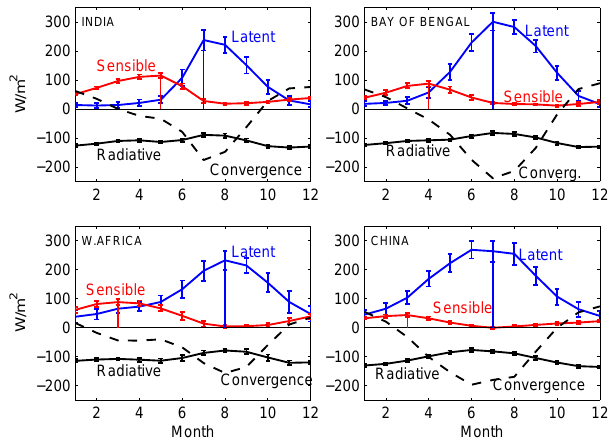
Fig. 2. Seasonal heat flux contributions to the atmospheric column over four major continental monsoon regions in NCEP/NCAR re- analysis data (Kistler et al., 2001). Radiative heating of the land surface in spring enhances sensible heat flux from the ground (“Sen- sible”). During the rainy season, latent heat release dominates the heat budget (“Latent”). Radiative heat flux comprises all radia- tive fluxes in and out of the atmospheric column (“Radiative”). The excess heat is transported out of the continental monsoon re- gion through large-scale advective and synoptic processes (“Con- vergence”). Error bars give the standard deviation from the reanaly- sis period (1948–2007). See Table 1 for the geographical definitions of the monsoon regions. The red and blue vertical lines emphasize the months of maximum sensible heat flux and latent heat flux, re-